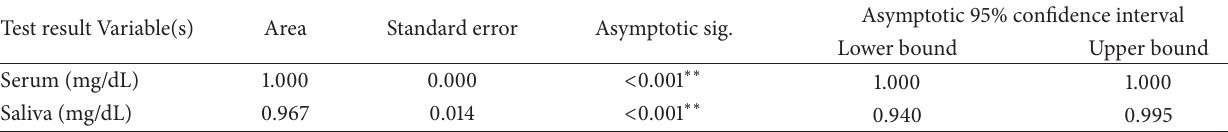
Table 4: Table showing area under the ROC curve.